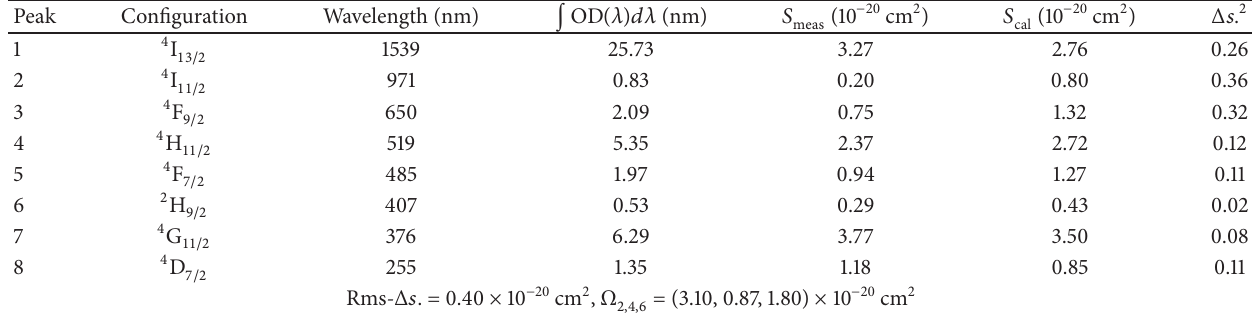
Table 1: Calculated strength parameters for Er 3+ in EBBO.